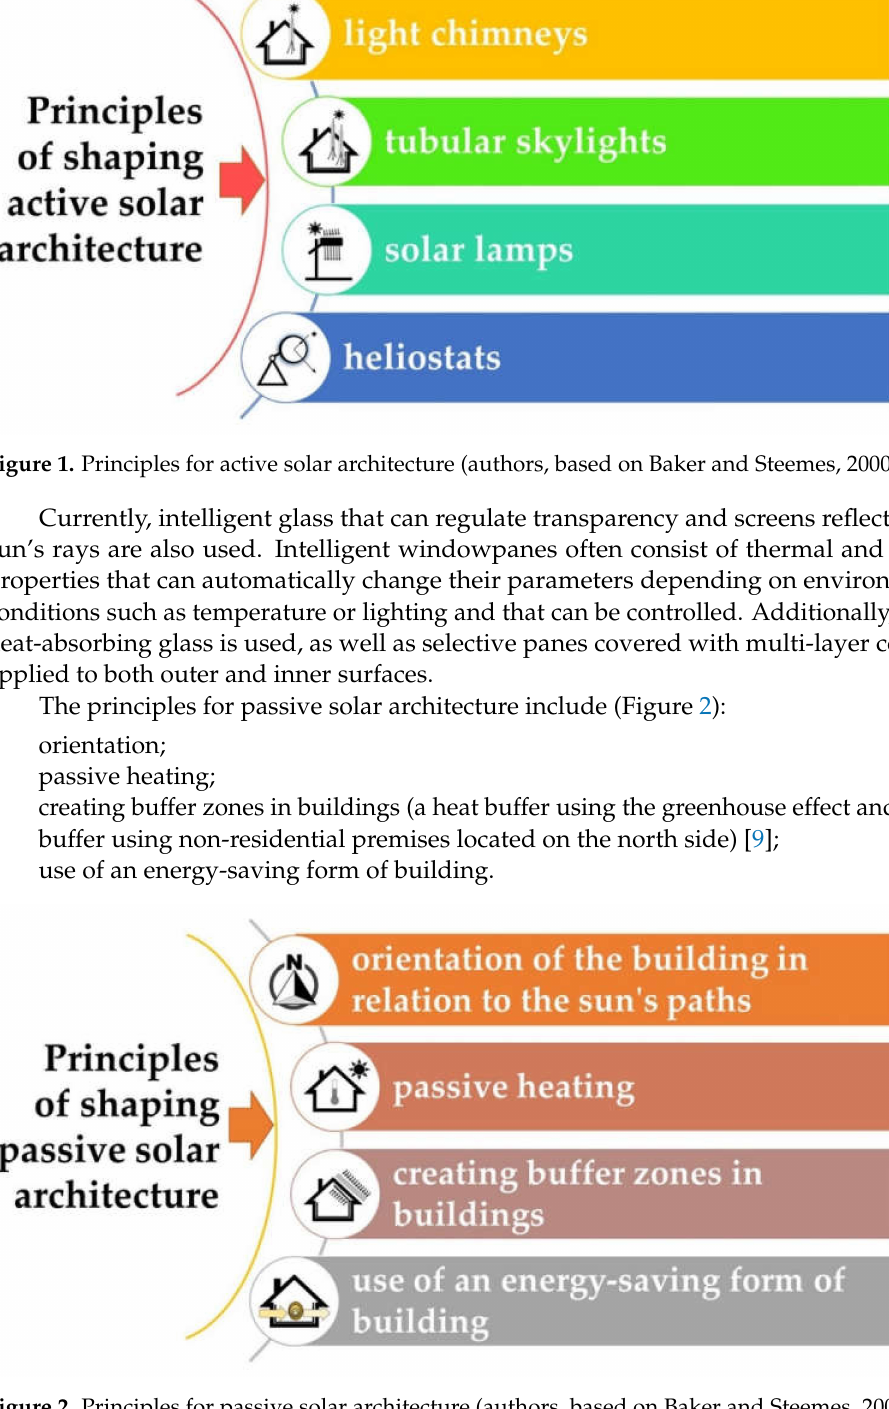
Figure 2. Principles for passive solar architecture (authors, based on Baker and Steemes,